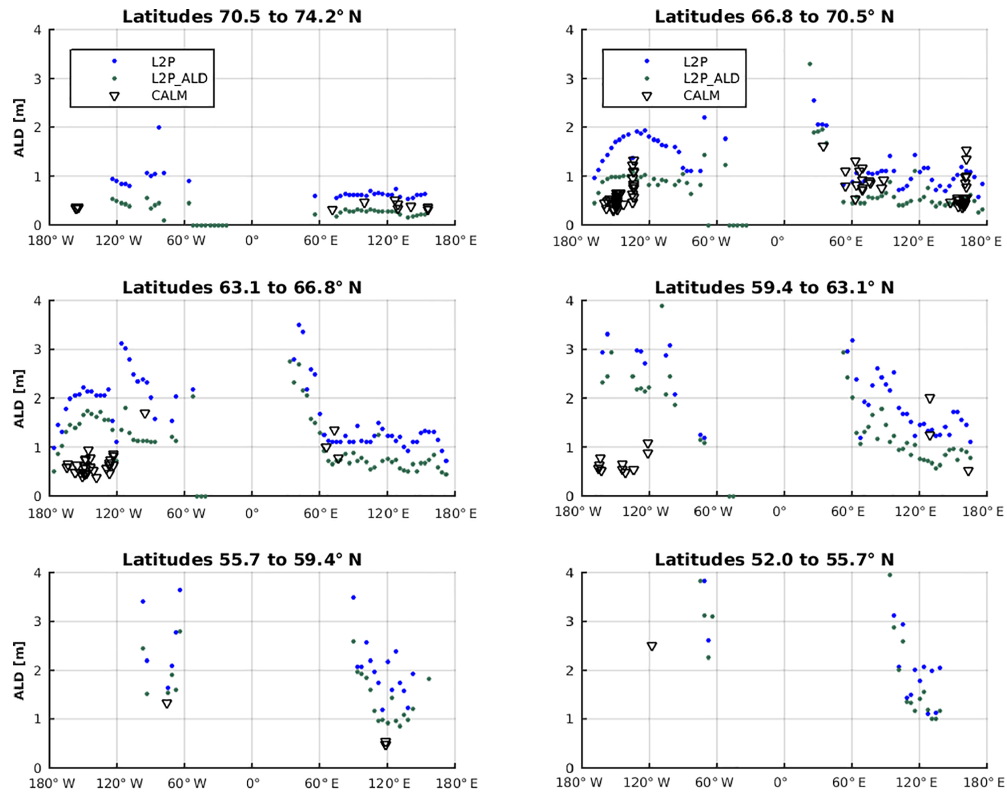
Figure A9. Latitudinal dependency of active layer depths (ALDs) inferred from JSBACH simulations (dots) and CALM observations (tri- angles). Blue dots represent the standard model experiment (L2P) and green dots the sensitivity run with increased thermal insulation of the organic surface layer